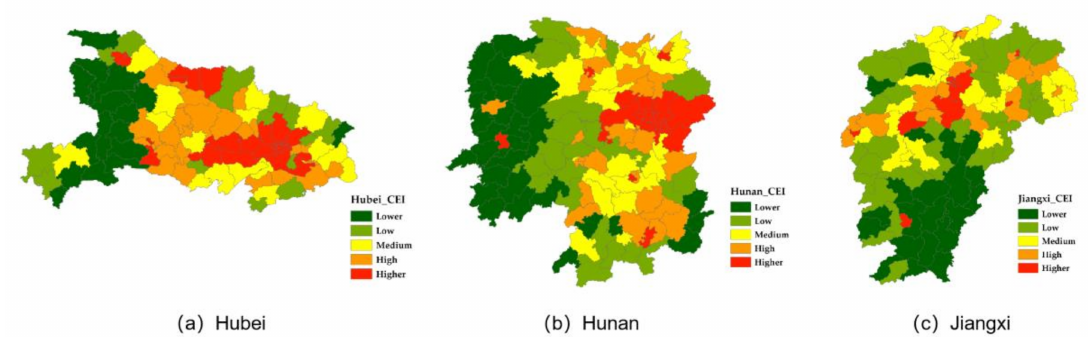
Figure 4. CEI distribution maps of Hubei, Hunan, and Jiangxi in 2018.